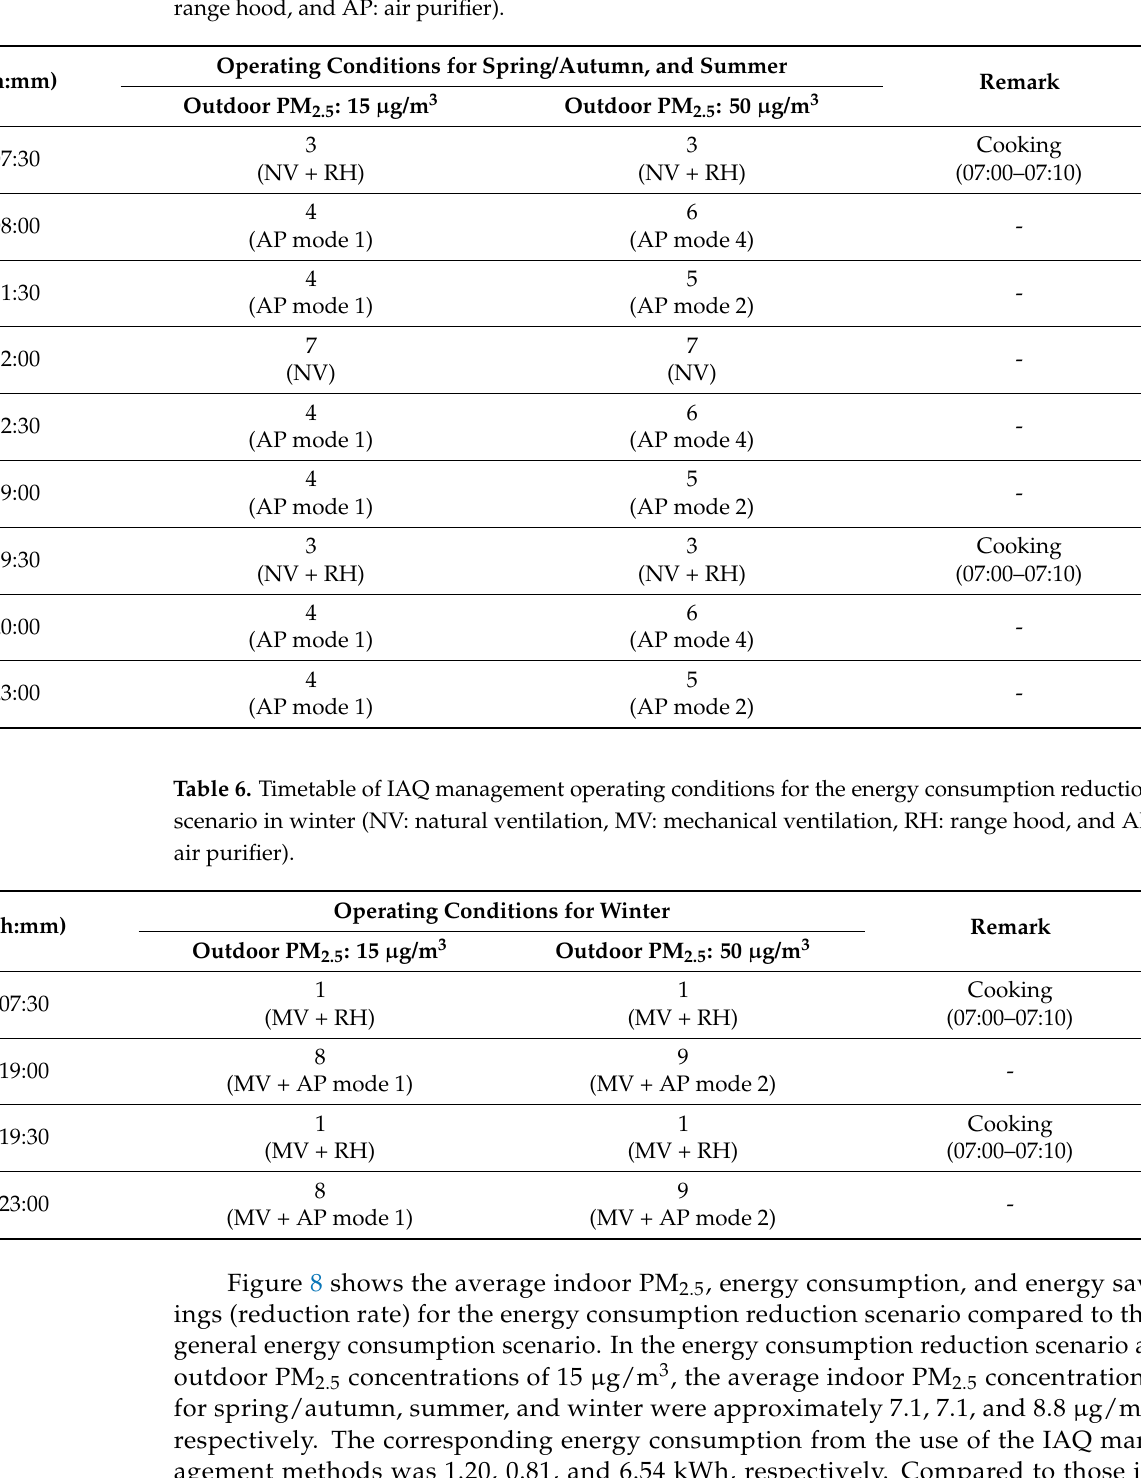
Table 5. Timetable of IAQ management operating conditions for the energy consumption reduction scenario in spring/autumn and summer (NV: natural ventilation, MV: mechanical ventilation, RH: range hood, and AP: air purifier).